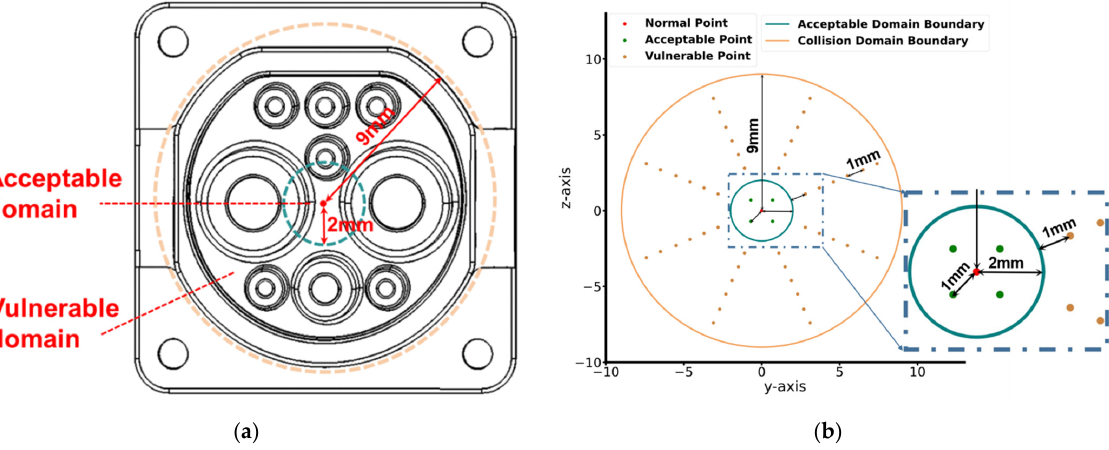
Figure 5. ( a ) The acceptable domain and the vulnerable domain of the charger; ( b ) the distribution of the designed collision points.